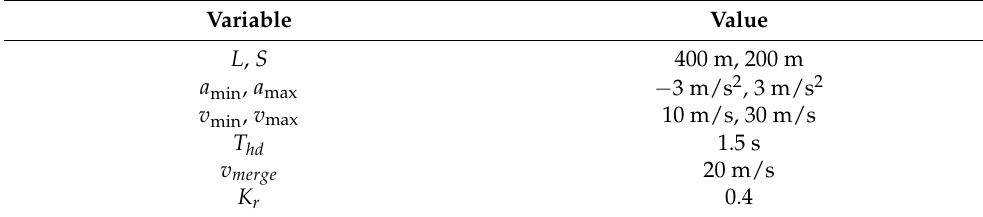
Table 1. Simulation parameters.